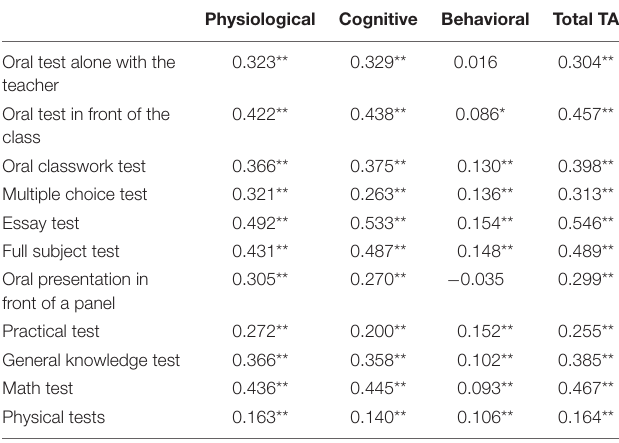
TABLE 8 | Pearson correlation coefficient between components of TA and anxiety in different types and subjects of the test. Physiological Cognitive Behavioral Total